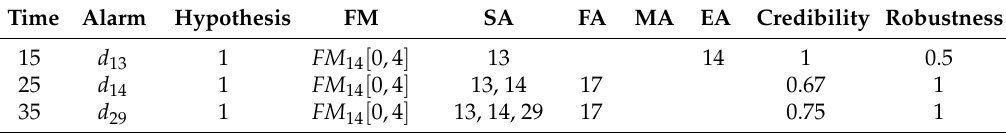
Table 3. Table of simulation results based on traditional TFPG method.